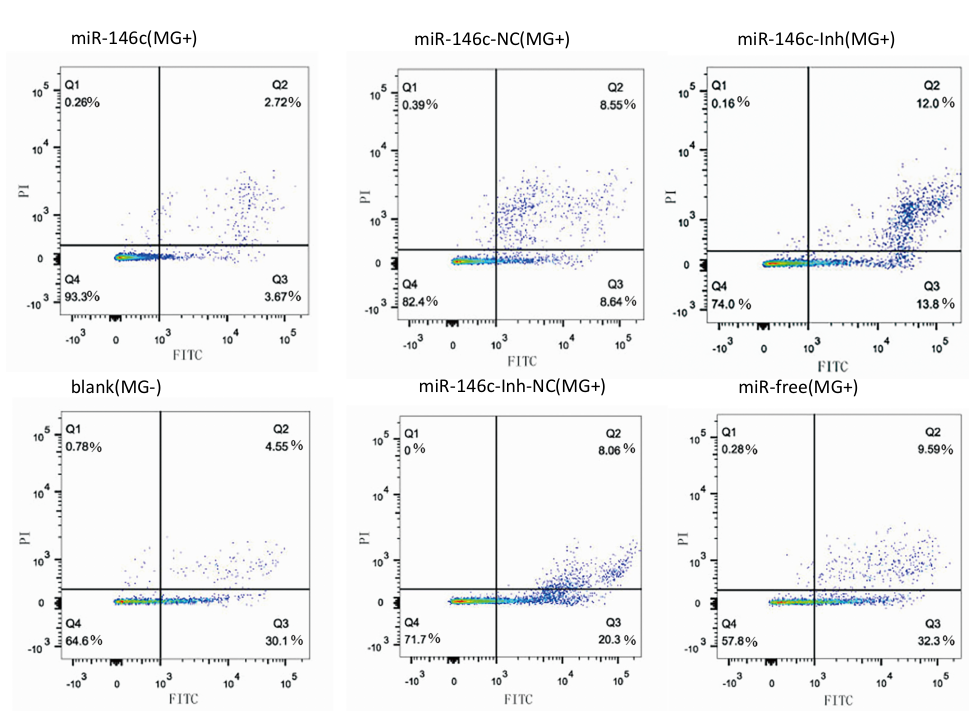
Figure 8. Cell apoptosis was influenced by gga-miR-146c. Four groups of transfection treatments were carried out. Values are mean ± SD, * P 0.05, ** P 0.01. ( A,C ) Cell apoptosis was significantly suppressed by gga-miR-146c overexpression; ( B,C ) Cell apoptosis was promoted with gga-miR-146c inhibitor.